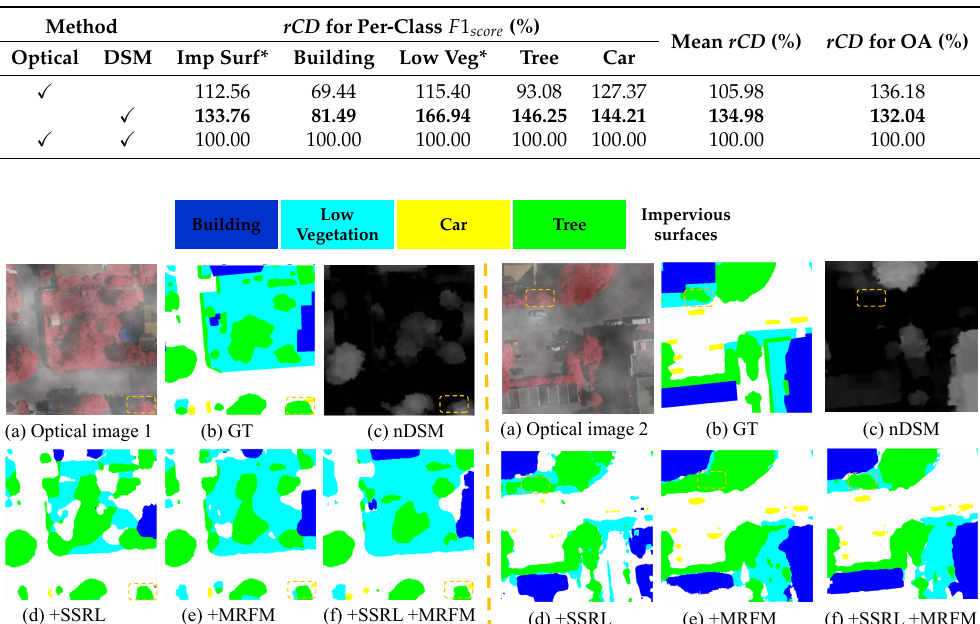
Table 7. Quantitative evaluation of rCD on clean and fog corrupted variants of the Vaihingen test set in ablation study about using different input data evaluated. Our framework is regarded as the reference and lower rCD indicates an improvement of robustness in the presence of fog corruption. The highest rCD is bold.